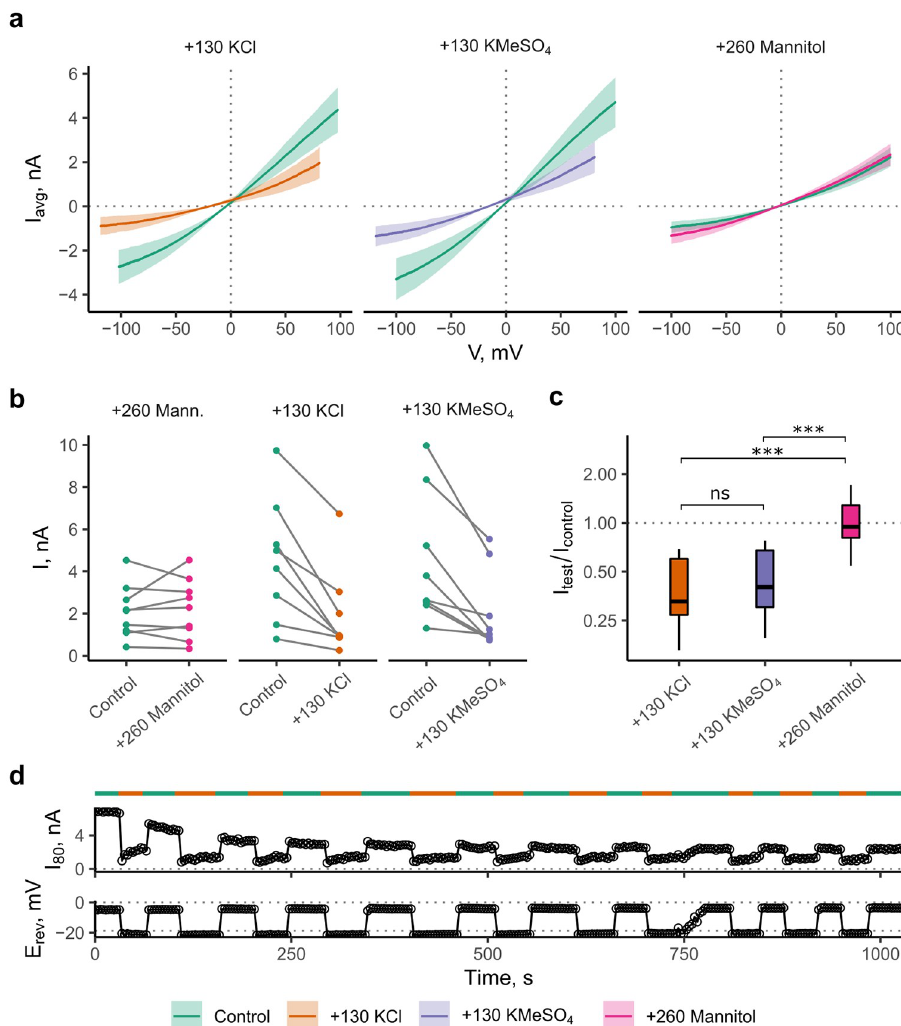
Fig 2. High ionic strength, not osmotic gradients inhibit TREK2. a ) Mean IV-curves in excised patches. Shaded areas represent ± SEM. One test solution was applied to every patch, then it was discarded (this yields separate control curves for every condition, n > 8 paired recordings). b ) Currents at +95 mV outward driving force. c ) Relative current change. The mannitol test solution has no appreciable effect on current. Multiple comparisons here were tested with ANOVA and Tukey’s post-hoc test. d ) Time course data of repeated application of 250 mM KCl solution to an inside out patch. Typical example shown from 3 independent measurements. Voltage ramps from -100 to +100 mV were continually applied to an inside-out patch. Full solution exchange was usually achieved in the course of 1 ramp (1.5 s) as shown by the expected change in reversal potential. Channel activity decreased spontaneously over the course of the measurement and then stabilized (rundown). The current size and relative reduction with these test solutions were variable, however every patch tested showed reduced current in response to application of more concentrated salt solutions to the intracellular side (see Fig 2b). By contrast, application of the mannitol solution failed to elicit a consistent reduction of the current. Statistical analysis revealed no differences between the inhibition produced by the two high ionic strength solutions (p =